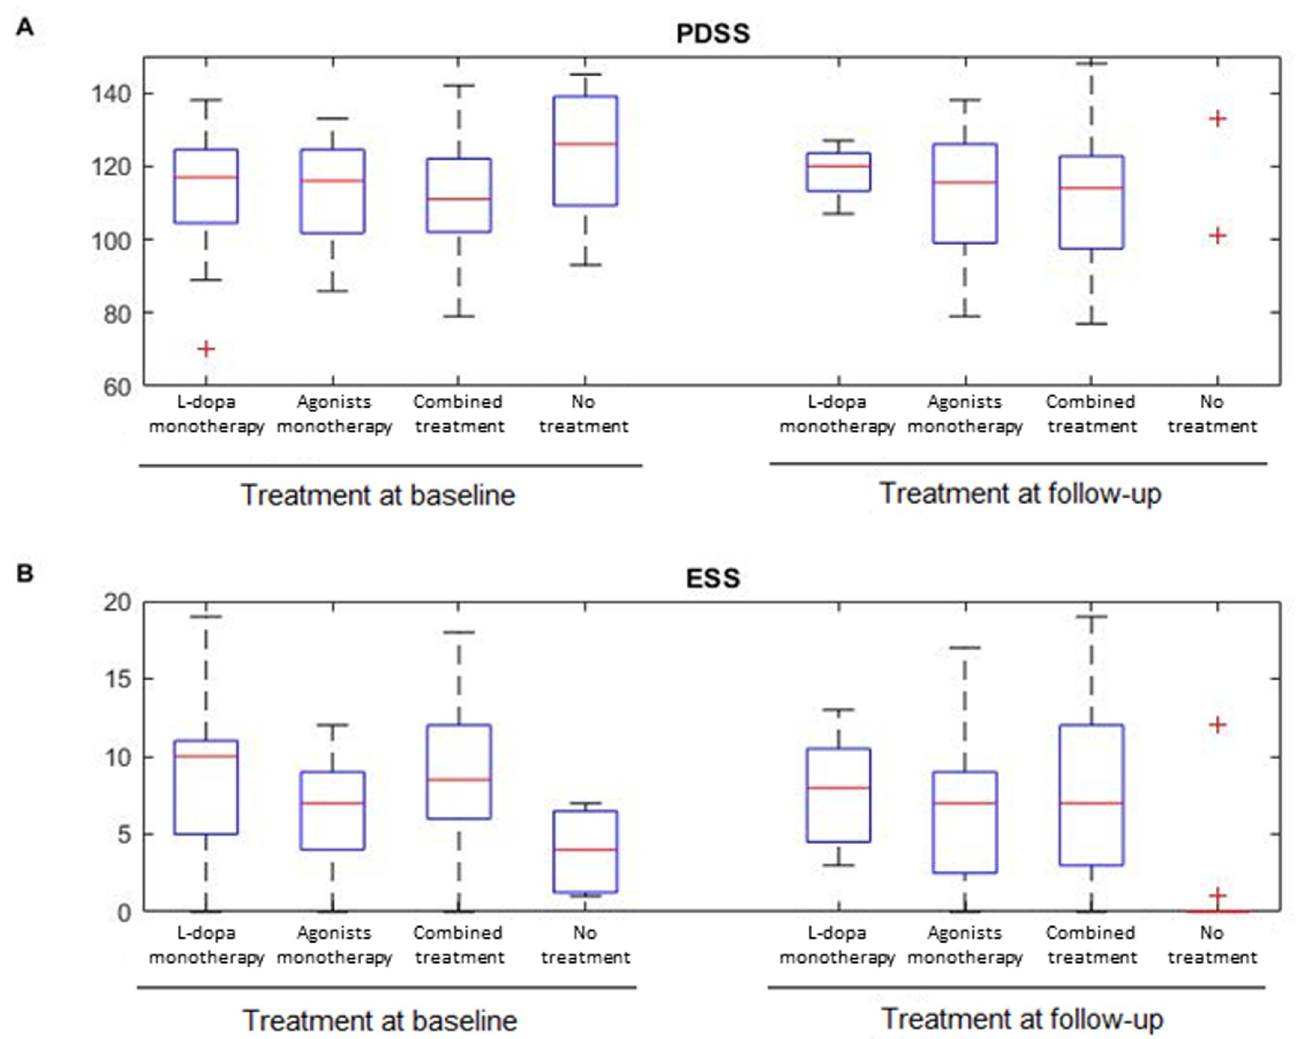
Fig 3. Differences between PDSS and ESS under different treatment. A. Scores of the PDSS of patients under dopaminergic treatment at baseline and at follow up. B. Scores of the ESS of patients under dopaminergic treatment at baseline and at follow up.